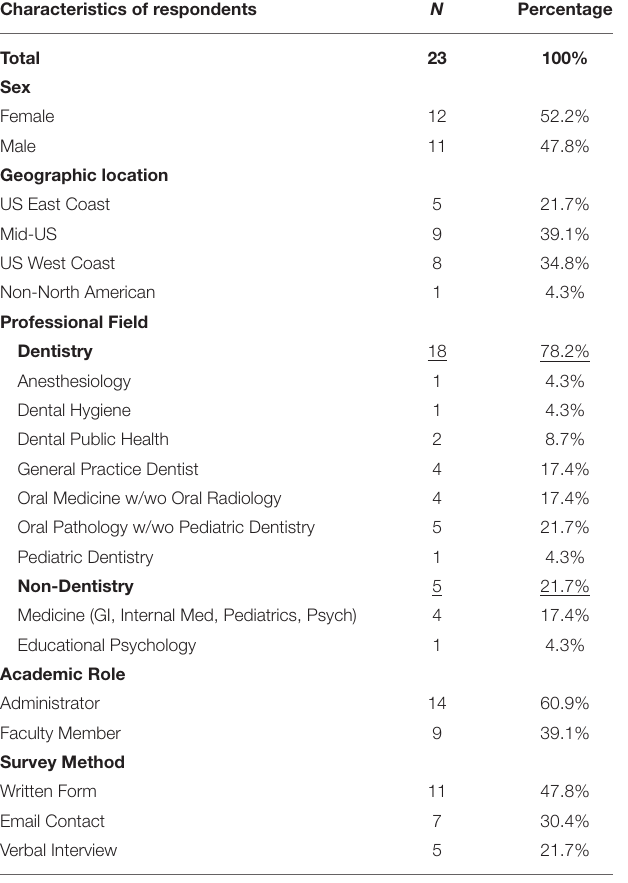
TABLE 3 | Characteristics of respondents.